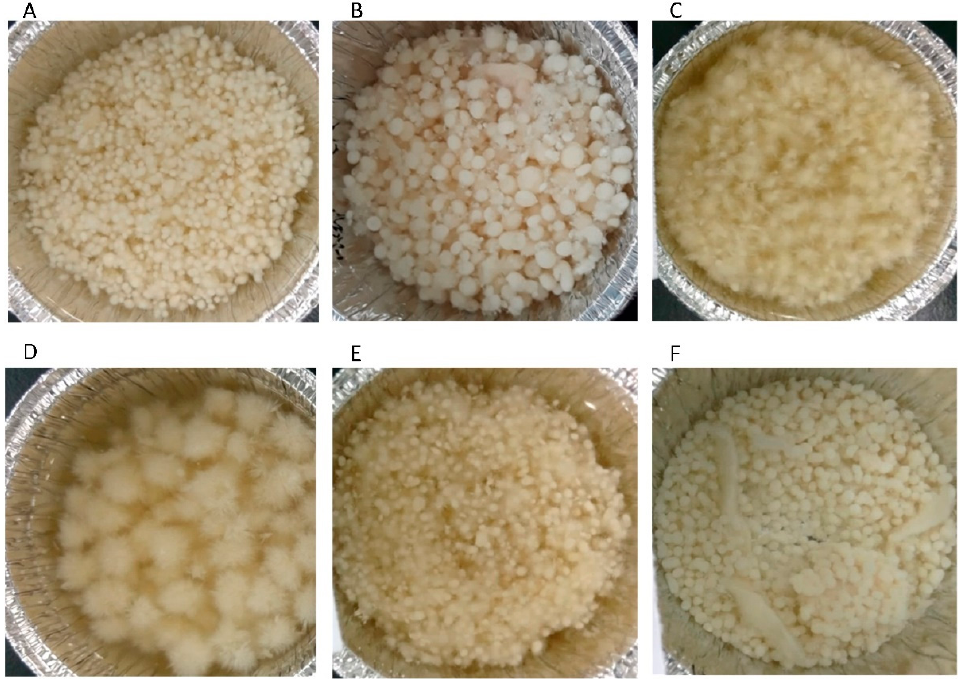
Figure 3. Morphology of Mortierella alpina FU30797 after 5 days of cultivation in different artificial sea salt concentrations. ( A ) 0 g/L; ( B ) 10 g/L; ( C ) 30 g/L; ( D ) 50 g/L; ( E ) 70 g/L; ( F ) 90 g/L.